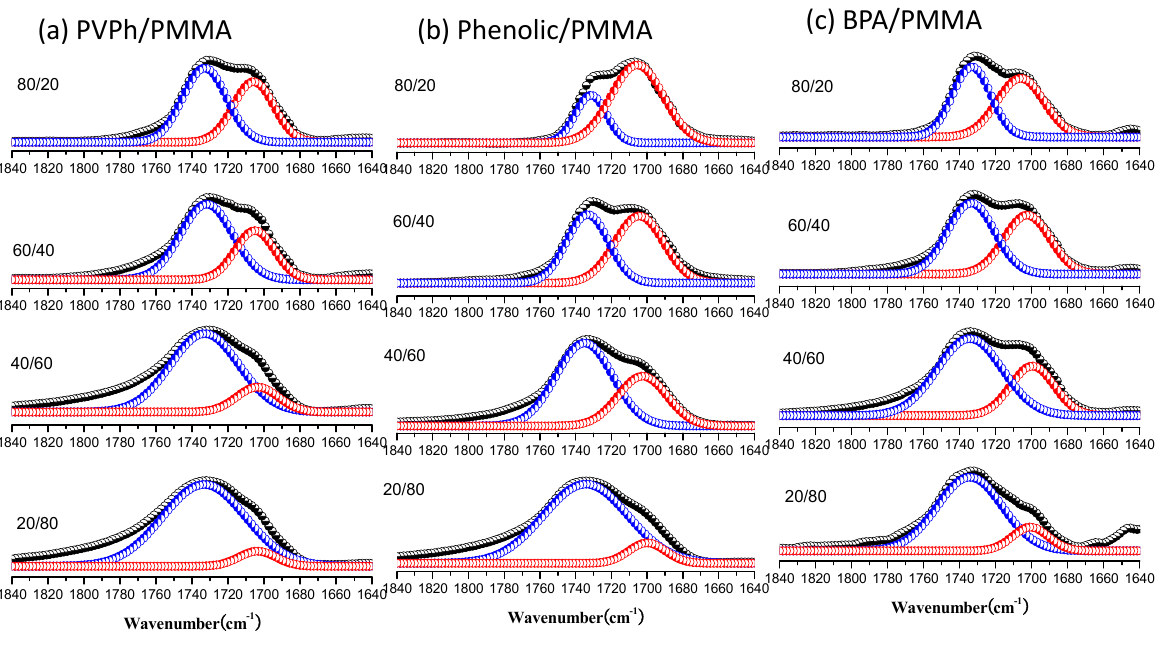
Table 2. Curve-fitting of the Fourier transform infrared (FTIR) spectroscopic data for the C=O groups of PMMA and its blends with PVPh, phenolic, and BPA. Sample